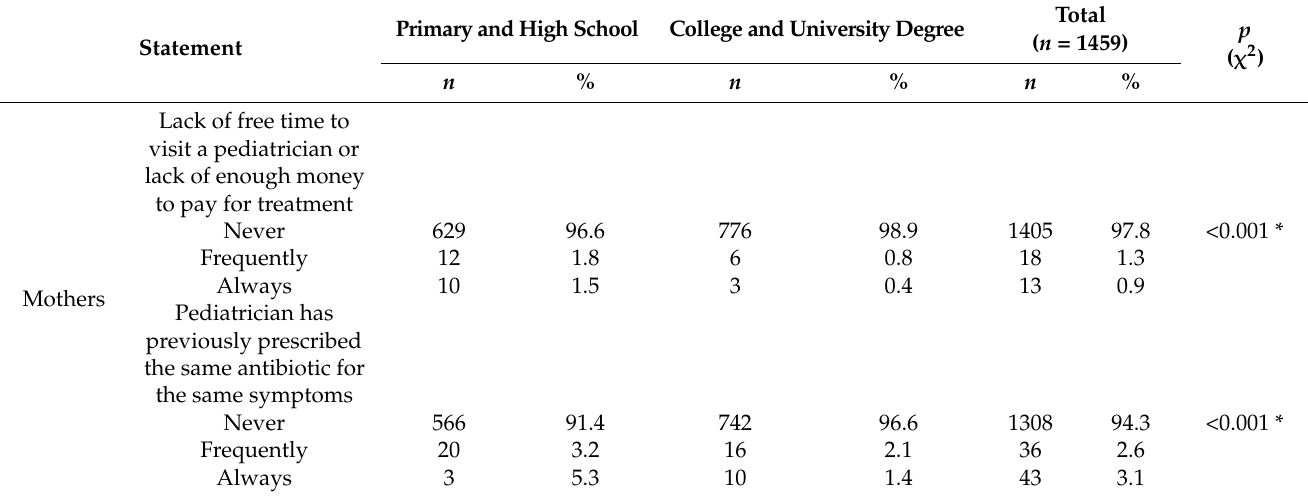
Table 7. Parental reasons for administering antibiotics without a pediatrician’s